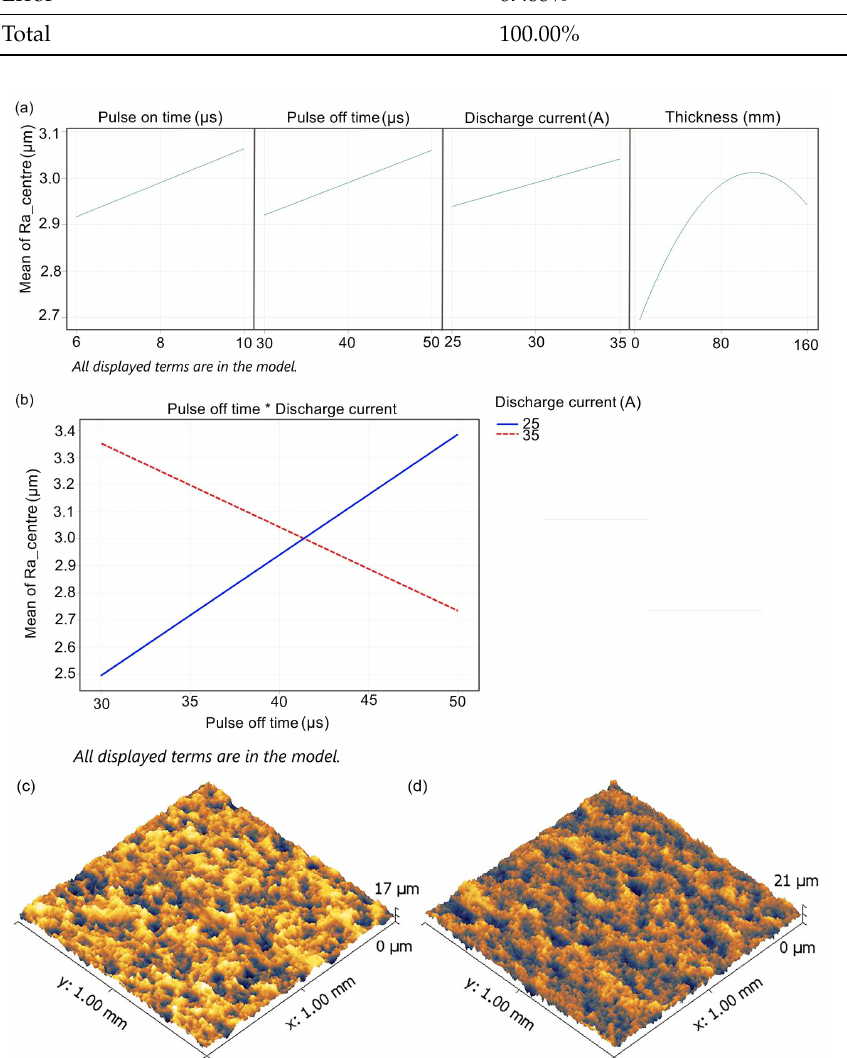
Figure 4. ( a ) Main effects of Ra_center, ( b ) graph interactions for Ra_center, ( c ) 3D relief of the sample’s surface at 5 mm thickness, ( d ) 3D relief of the sample’s surface at 160 mm thickness.